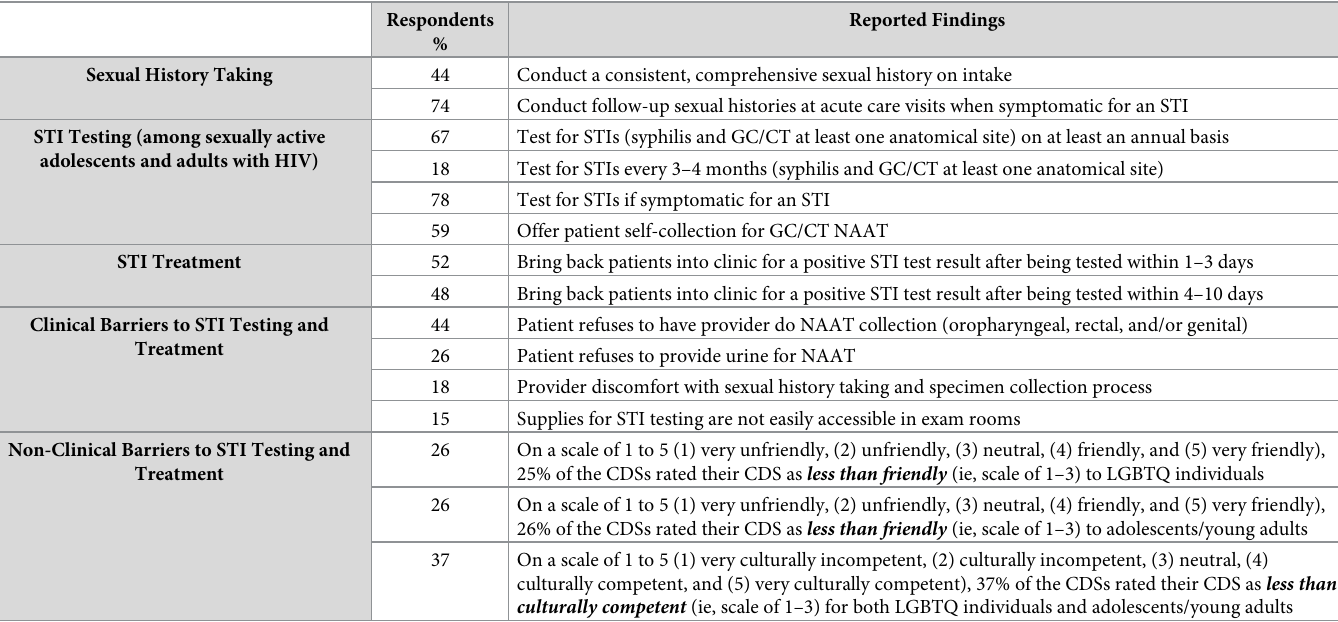
Table 2. Clinical team member process, attitudes & beliefs